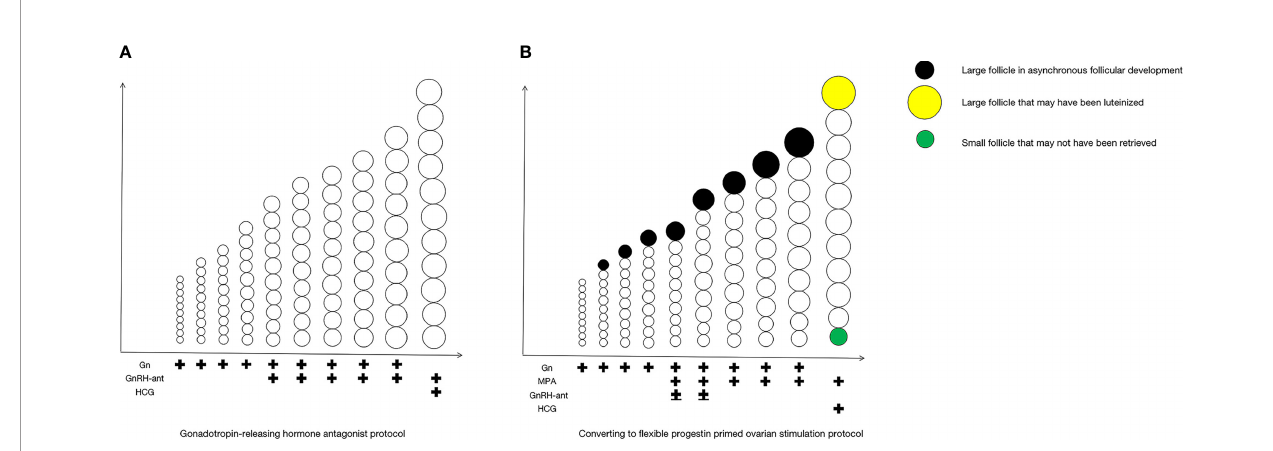
FIGURE 1 | COS process of fi xed GnRH antagonist protocol and fPPOS stimulation protocols with asynchronous follicular development. The COS process of the fi xed GnRH antagonist protocol in (A) , and the COS process of the fPPOS stimulation protocols in (B) . COS, controlled ovulation stimulation; Gn, gonadotropin; GnRH-ant, gonadotropin-releasing hormone (GnRH) antagonists; HCG, human chorionic gonadotropin; MPA, medroxyprogesterone